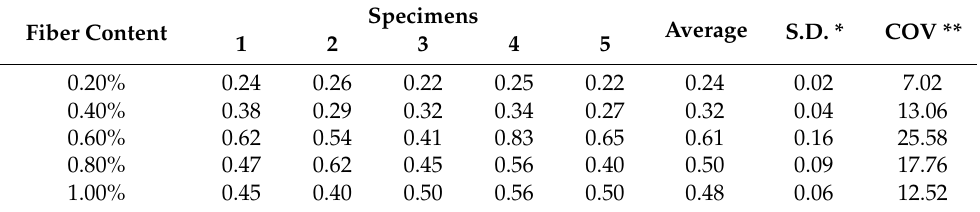
Table 6. Residual strength at L /150 (MPa).